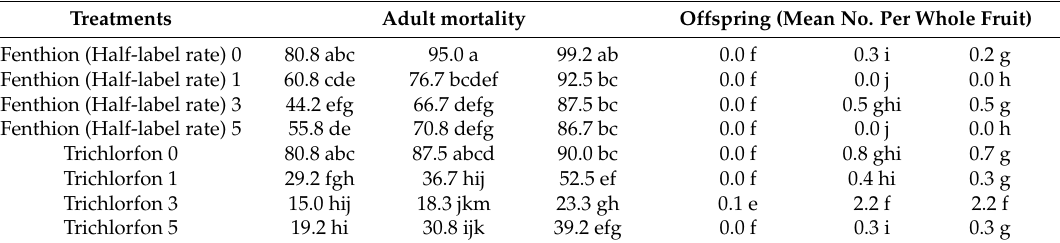
Treatments Adult mortality Offspring (Mean No. Per Whole Fruit) Fenthion (Half-label rate) 0